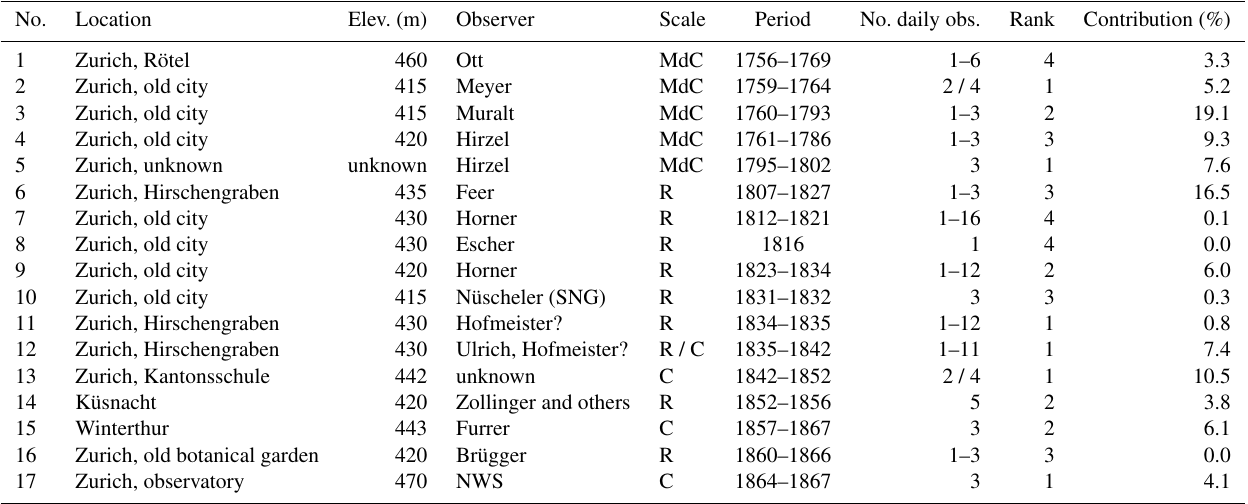
Table 2. Records contributing to the daily temperature series of Zurich (elevations are estimated). No. Location Elev. (m) Observer Scale Period No. daily obs.